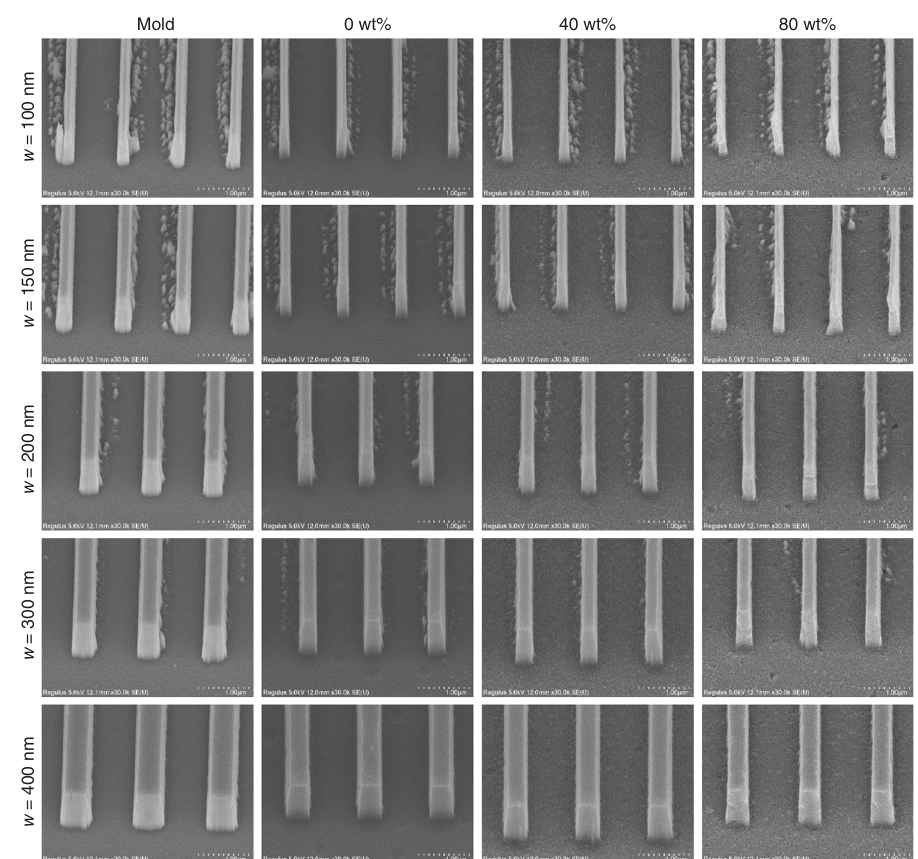
Fig. 5 Comparison of fabrication quality for line arrays. The titanium dioxide weight ratio varies from 0 to 80% while the width w of lines changes from 100 to 400 nm. The height of line structures of the master mold is 1.2 µ m, and all the patterns are tilted by 30°. It is worth noting that the electron beam